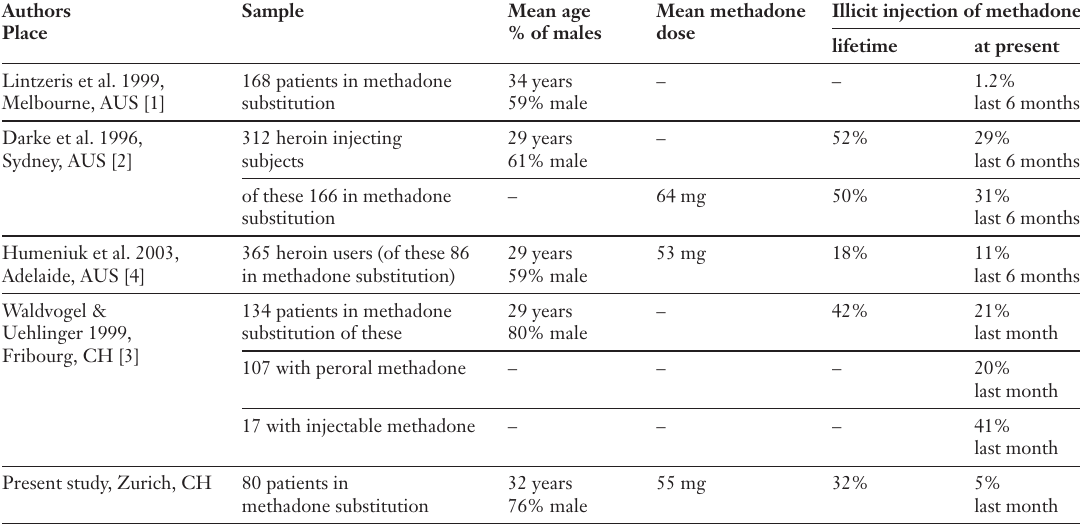
Results of studies on illicit methadone